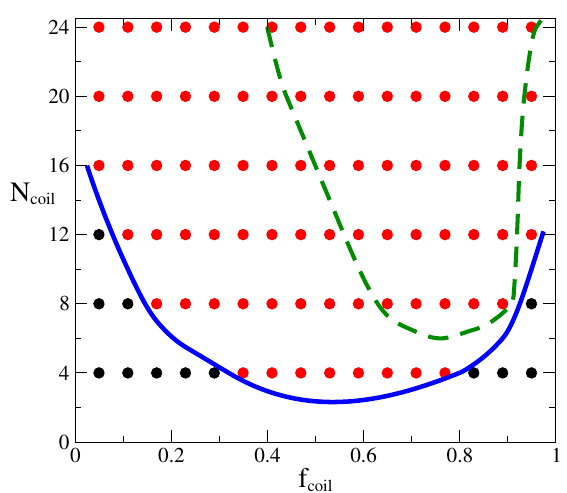
Figure 5. Phase diagram in the parameter space ( f coil , N coil ) for a mixture of rigid and flexible polymers, obtained by Monte Carlo simulations. Red circles indicate the points in the phase diagram that give rise to phase separated samples while black circles represent those conditions for which a single phase is obtained. Lines are only a guide to the eye and highlight the phase boundary, these lines were obtained by using splines on the simulation data. Symbols and continuous (blue) line are results for κ coil = 0.25 ( (cid:96) p ≈ 0.44 b ), κ stiff = 5.0 ( (cid:96) p ≈ 4.5 b ) and µ = 4.0. The dashed green line is the phase boundary obtained for a sample with less dissimilarity between polymers, characterized by κ coil = 2.0 ( (cid:96) p ≈ 1.6 b ), κ stiff = 5.0 and µ =